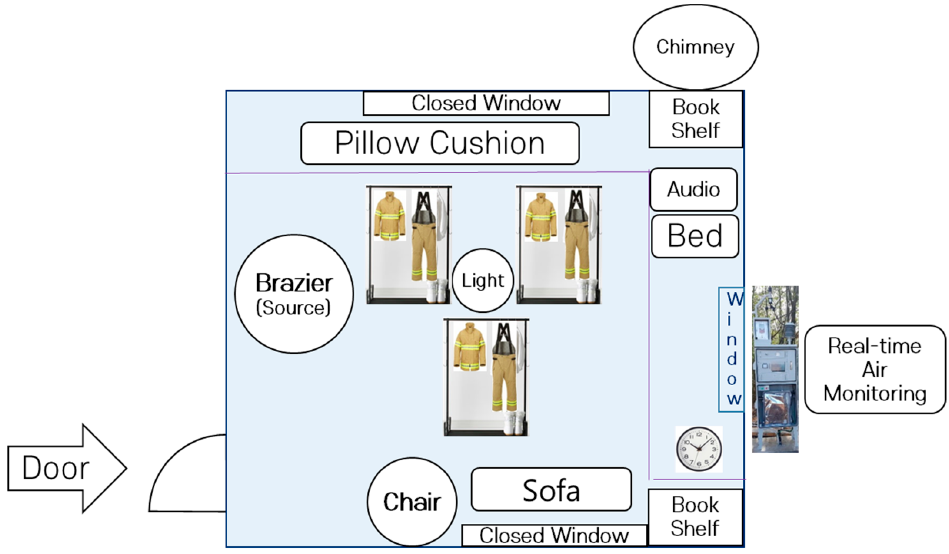
Figure 1. Schematic diagram of experimental scene .